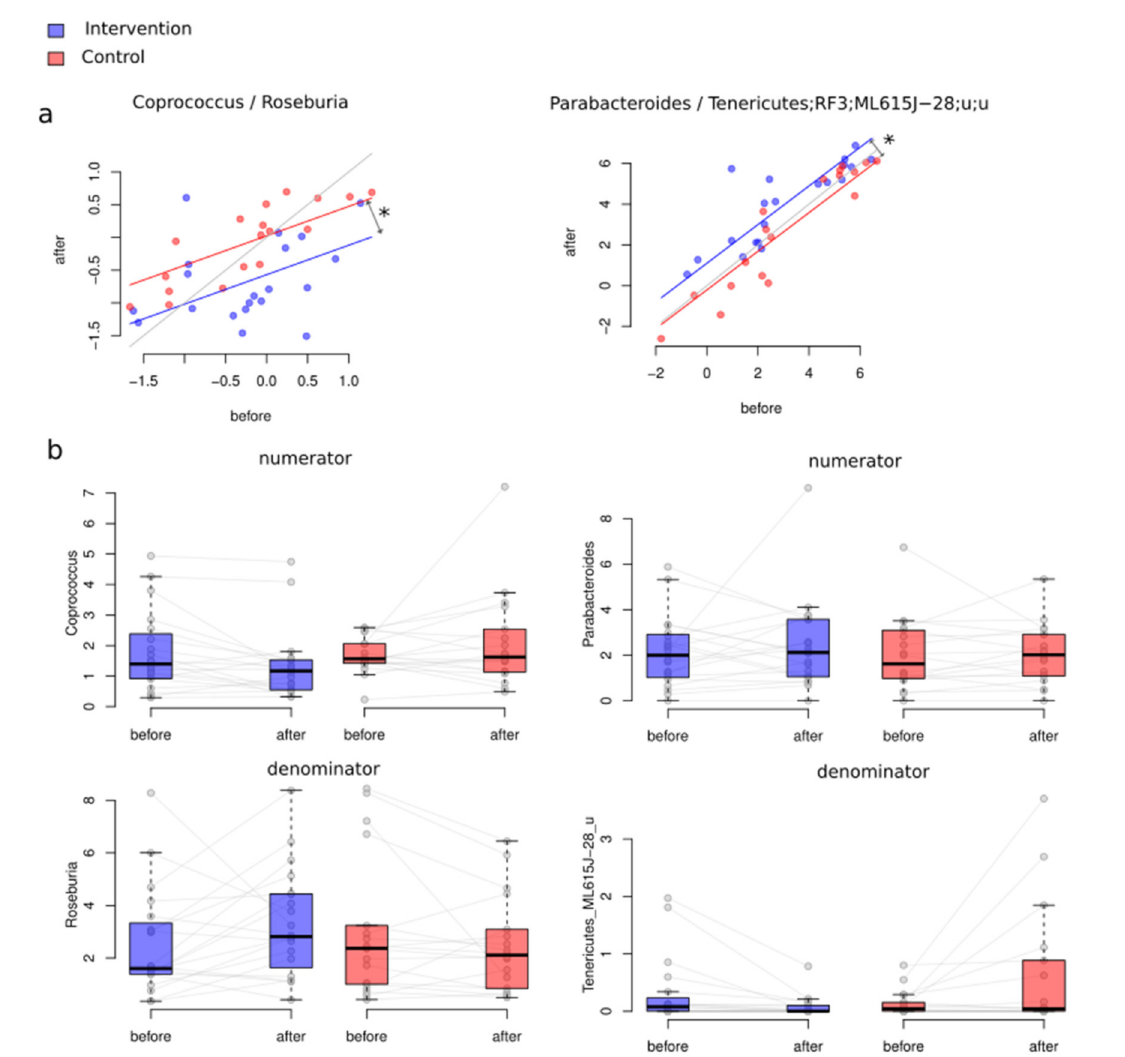
Figure 5. ( a ) Between-group differential abundance analysis results. Significantly changed balance values before and after the intervention in both the control and the intervention groups. Figure interpretation is as follows: There is one point per participant. If the point is under the grey line, for the participant, the balance decreased. If the point is above the line, the balance increased. Asterisks denote significant associations (FDR < 0.05). ( b ) The relative abundance of the taxa included in numerators and denominators of significantly changed balances (%). If we consider these relative abundances, it can be suggested that the main impact in the second balance was provided by unclassified